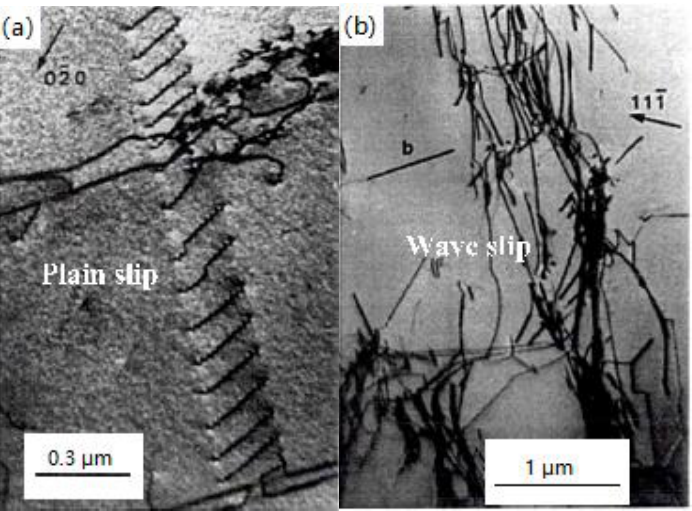
Figure 12. Dislocation plane slip structure ( a ) and wavy slip ( b ) [40].